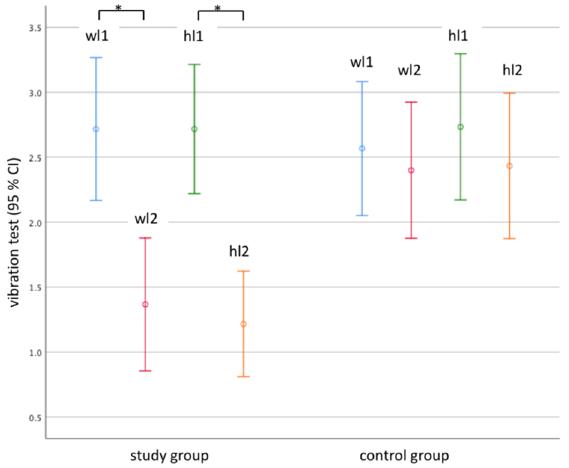
Figure 2. Vibration sensation test before and after the treatment. * p <